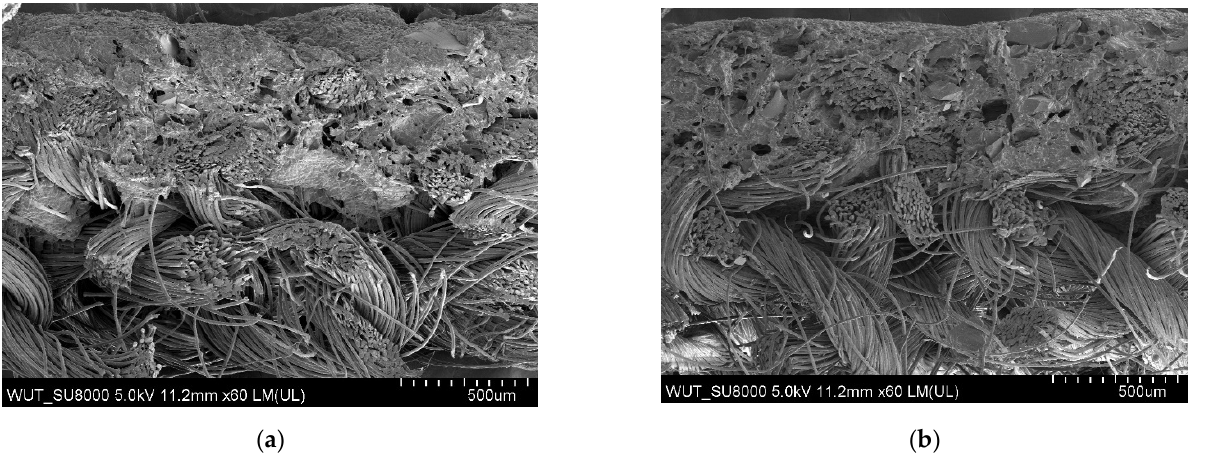
Figure 6. ( a ) SEM image of coating incorporating SiO 2 + CaO with a particle size of 50–200 µm (additive 8). ( b ) SEM image of coating incorporating SiO 2 + CaO with a particle size of 10–250 µm (additive 9).